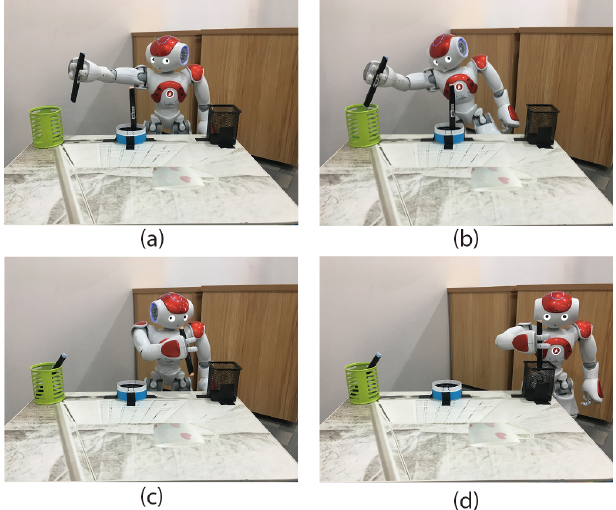
Figure 18. Description of the teleoperation task; ( a ) shows that the robot cannot reach the green container in the double-support mode; ( b ) shows that when the robot leans rightward in the single-support mode, it can easily reach the container; ( c ) shows that the robot cannot reach the black container in the double-support mode; ( d ) shows that when the robot walks leftward, it can easily reach the